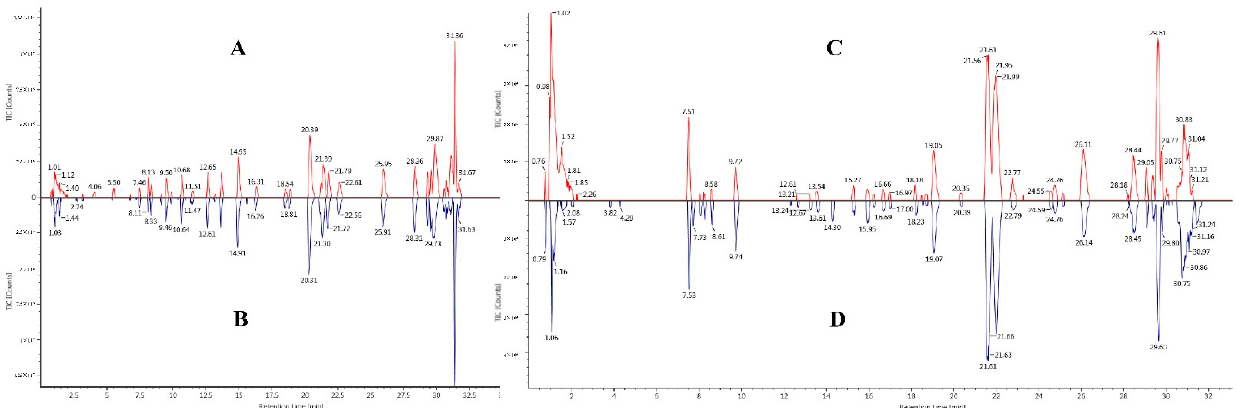
Figure 1. Typical total ion chromatogram (TIC) of SHLE before fermentation (( A ): positive ion mode; ( C ): negative ion mode) and SHLE after fermentation (( B ): positive ion mode; ( D ): negative ion